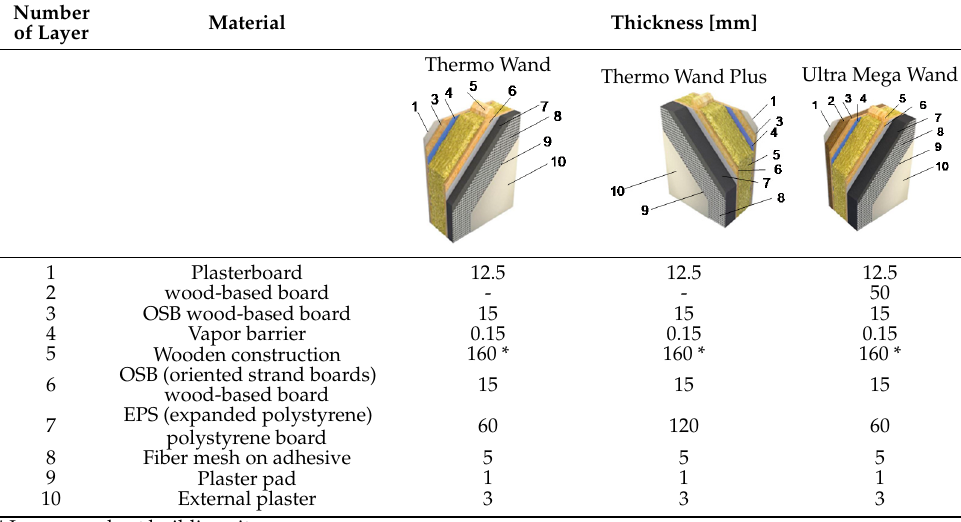
Table 1. Wall made in the system Wolf Thermo, Wand/Thermo, Wand Plus/Ultra Mega Wand. Number of Layer